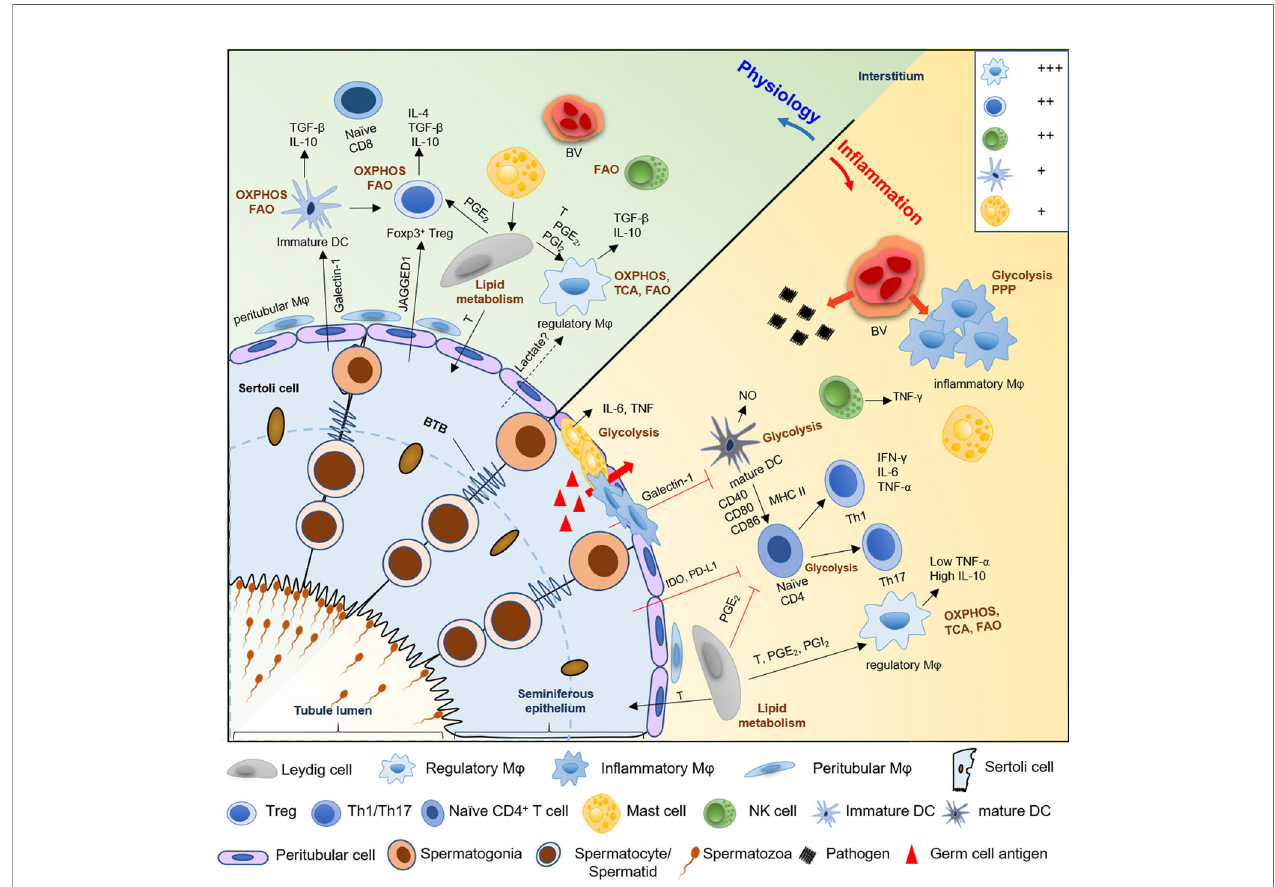
FIGURE 2 | A schematic diagram of the hypothetical metabolic homeostasis of immune cells in testes under physiological or in fl ammatory condition. In normal testes, immunologically tolerant cell phenotypes, comprising with macrophages (M j ), immature DCs, Tregs, and regulatory NK cells, principally rely on OXPHOS and fatty acid oxidation pathway to fuel immunosuppressive functions and synthesis of anti-in fl ammatory cytokines (e.g., IL-10 and TGF- b ). However, when testes suffer from pathogens or germ cell antigens attack, the number of macrophages and mast cells are markedly increased, and the location of these cells partially shift from the interstitium to the tubular compartment of infertile men testes. Furthermore, in fl ammatory phenotype cells such as in fi ltrating macrophages, mature DCs, effector T helper cells, and mast cells markedly show a metabolic shift towards the anaerobic glycolytic pathway to meet the rapid energy requirements and increased demands for synthesis of proin fl ammatory cytokine, like IL-6, NO and TNF- a . Then this cause ‘ cytokine storm ’ to disrupt the delicate equilibrium between immune privilege and tolerance, which trigger testes in fl ammation and impair normal spermatogenesis, followed by male infertility. Meanwhile, Sertoli cells also contribute to the immune-privileged status of mammalian testes, especially, maintain immature DCs, and inhibit effector T cells and NK cells via paracrine cytokines IDO and PDL- 1. Similarly, Leydig cells play an immunoregulatory effect on maintenance of regulatory macrophage phenotype and inhibition of T cells immune responses through secreting lipid metabolites, such as testosterone, PGE 2 and PGI 2 . Treg, regulatory T cells; DC, dendritic cell; Th, T helper cell; FAO, fatty acids oxidation; OXPHOS, oxidative phosphorylation; TCA, tricarboxylic acid; PPP, pentose phosphate pathway; T, testosterone; PGE2 and PGI2, prostaglandins E2 and I2; IDO, indoleamine 2,3-dioxygenase; PDL-1, programmed death ligand-1; NO, nitric oxide; BV; blood vessel. +++, most abundant; ++, relatively abundant; +, present